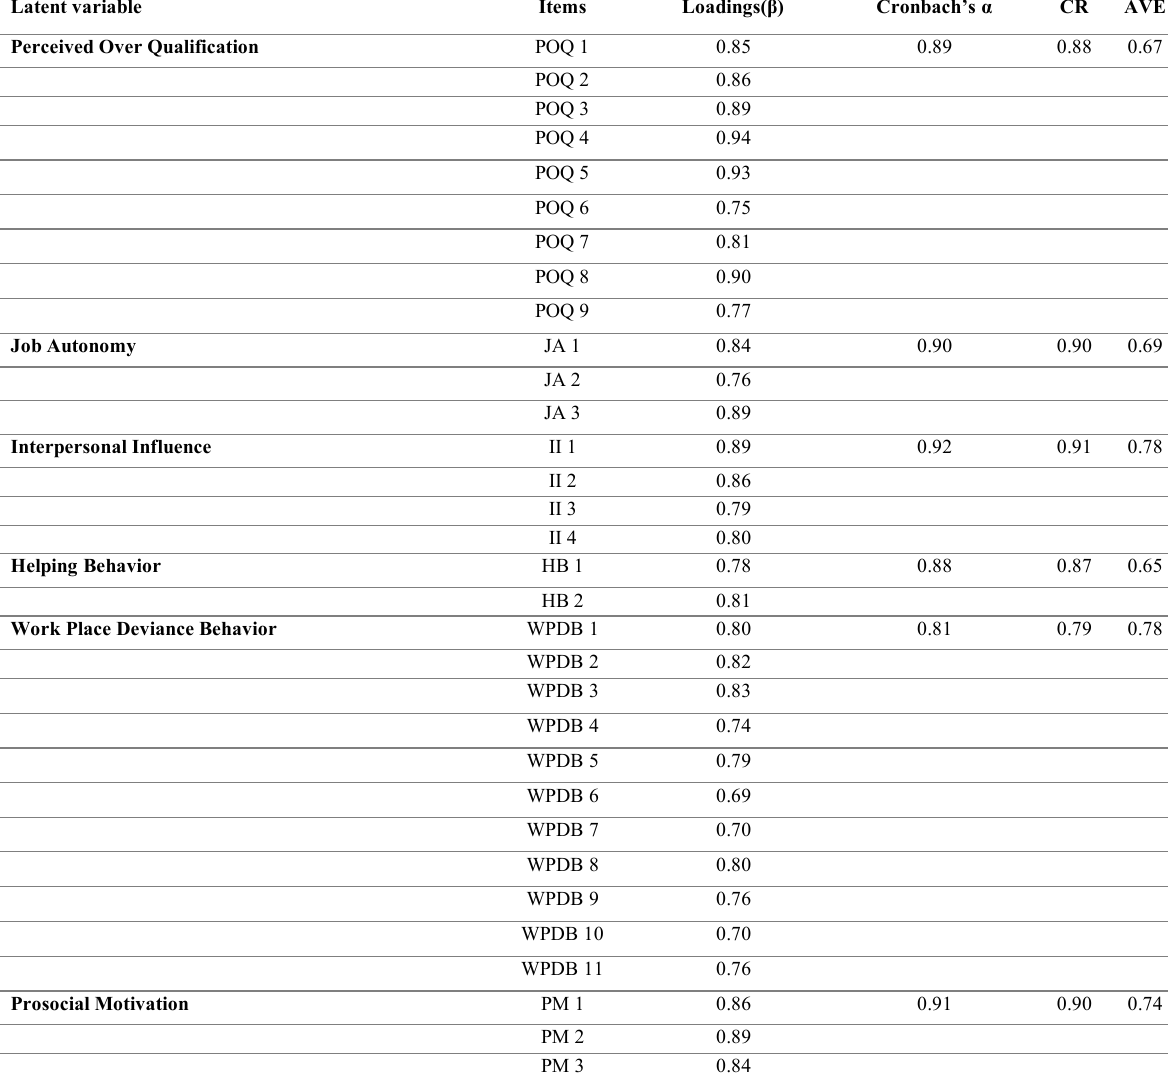
Table 1. Results of CFA